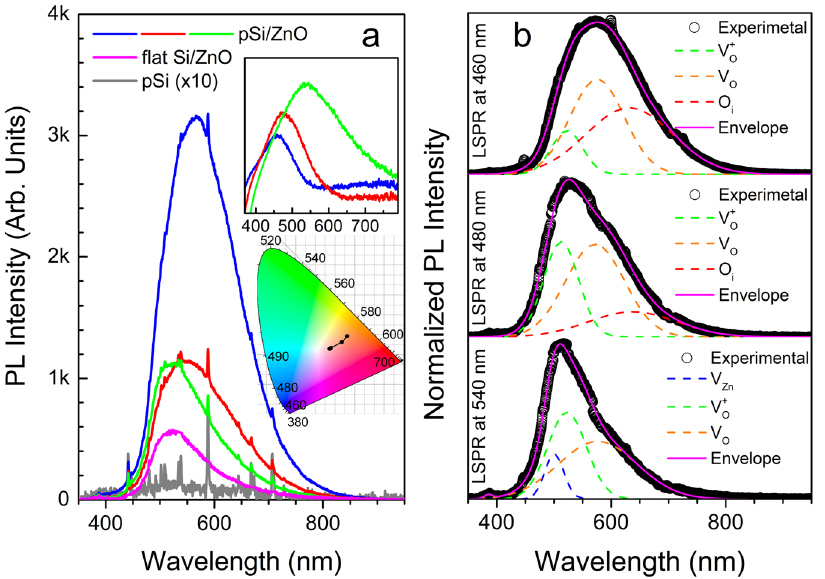
Figure 5. ( a ) PL spectra of the pSi/ZnO samples fabricated using pSi substrates with different pore sizes. The upper inset presents the reflectivity spectra of the Ag NPs used for the Si etching, in matching colors; thus, the finest and widest pores correspond to the blue and green PL and reflectivity spectra, respectively, while the red spectra are the intermediate case. Also shown are the PL spectra of bare pSi after thermal oxidation at 500 °C for 1 h ( × 10) and of a ZnO thin film electrodeposited on top of a flat Si with identical conditions to the pSi/ZnO; the lower inset shows the color coordinates of the emitted light from pSi/ZnO within the CIE scheme. ( b ) Deconvolution of the normalized PL spectra of pSi/ZnO to contributions originating from various point defects in